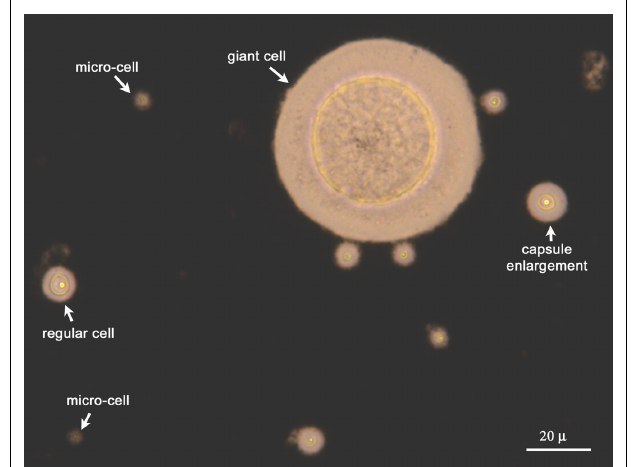
FIGURE 1 | Heterogeneity of fungal population extracted from the lungs of infected mice. The yeast cells isolated from the lungs of infected mice were isolated and suspended in India Ink to visualize the capsule. As shown, multiple forms of C. neoformans (regular cells, cells with enlarged capsule, fungal giant/titan cells, and microforms) are present during